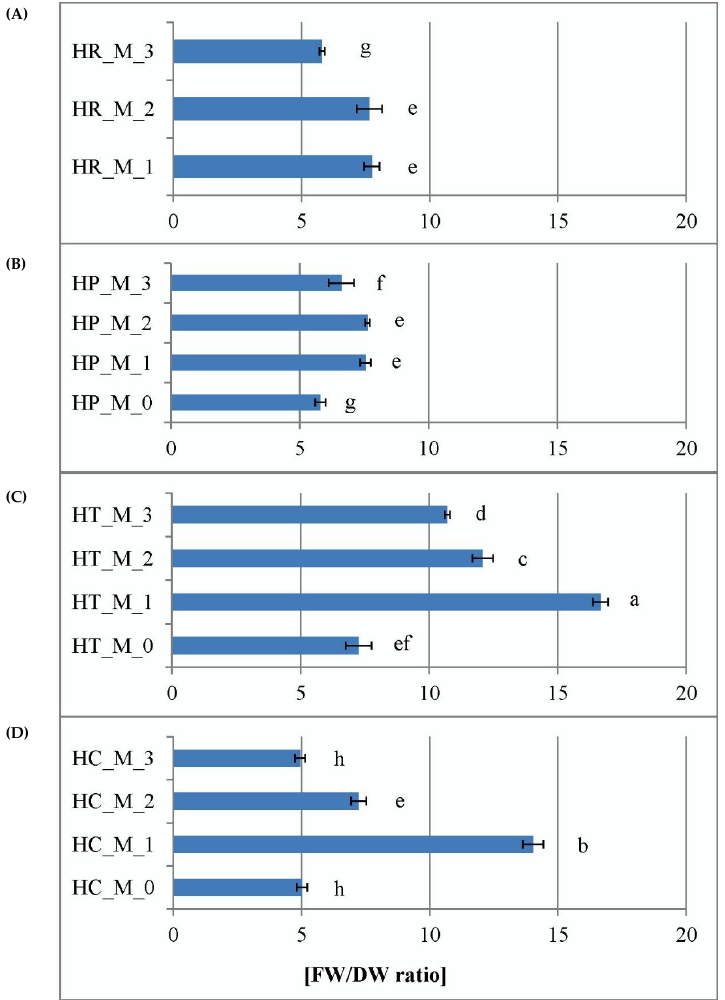
Figure 3. Effect of plant growth regulators on tissue hydricity in Hypericum ssp. studied in vitro. M_0—PGR-free ( A ), M_1—0.2 mg/L BA ( B ), M_2—0.2 mg/L BA + 0.1 mg/L IBA ( C ) and M_3—0.1 mg/L BA + 0.2 mg/L IBA ( D ) supplemented media, HR— H. richeri Vill., HP— H.